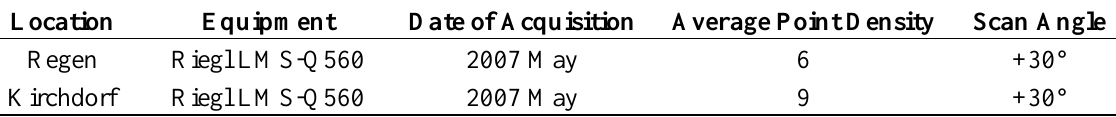
Table 1. Property summary of the two data